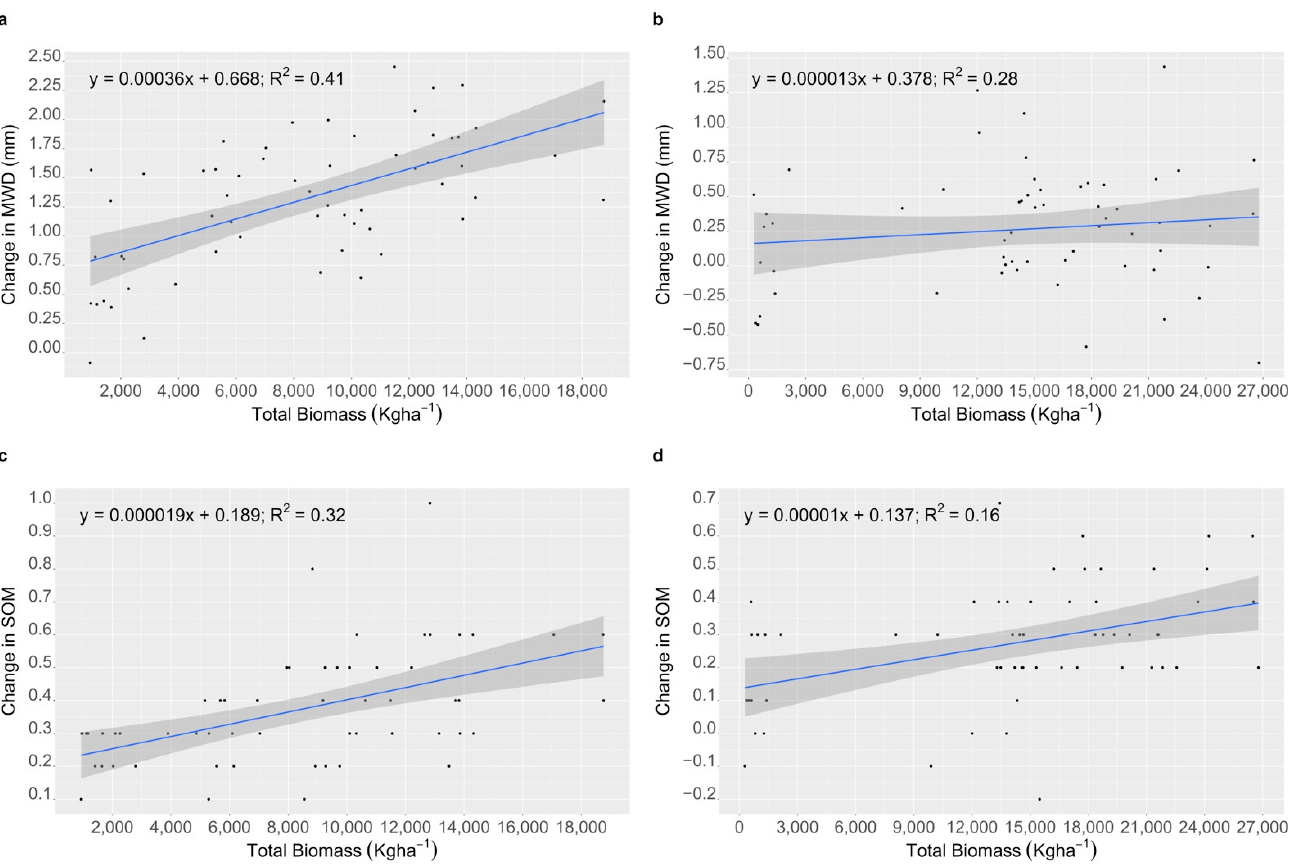
Figure 3. Change in mean weight diameter (MWD) at ( a ) Leyendecker and ( b ) Los Lunas and change in soil organic matter (SOM) at ( c ) Leyendecker and ( d ) Los Lunas from 2018 to 2020 in response to total biomass produced during cover crop growth phase.